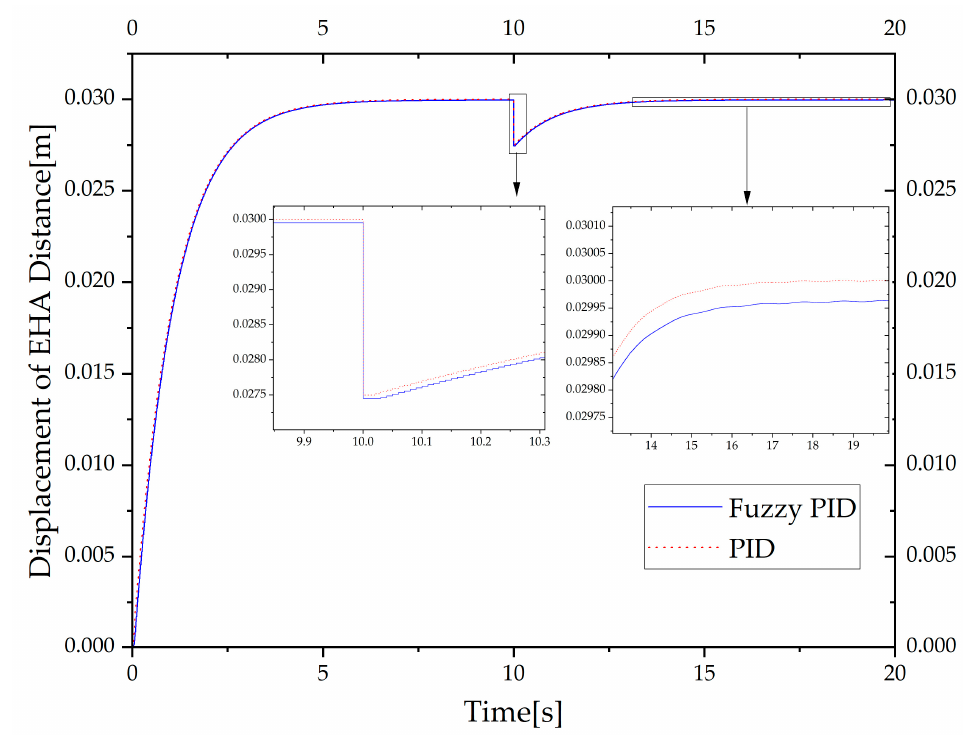
Figure 21. Fuzzy PID versus PID.